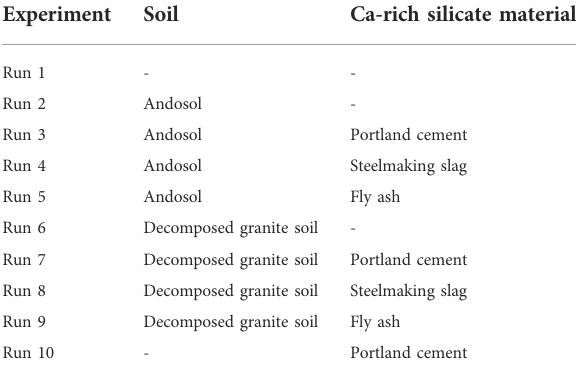
TABLE 2 Combination of soil and Ca-containing silicate material in each batch-type